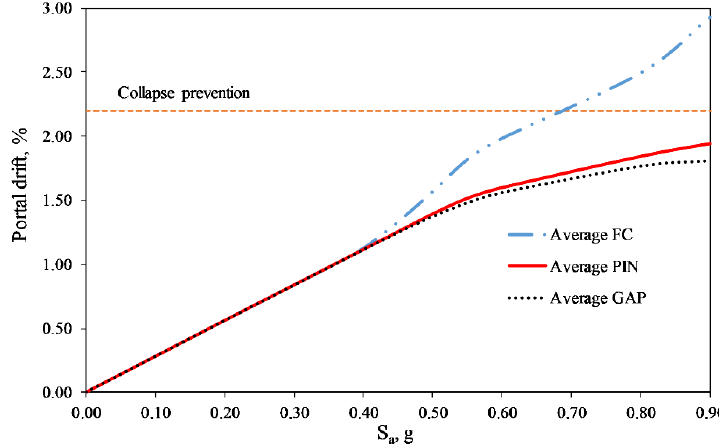
Figure 12. The portal drift of the FC boundary condition.